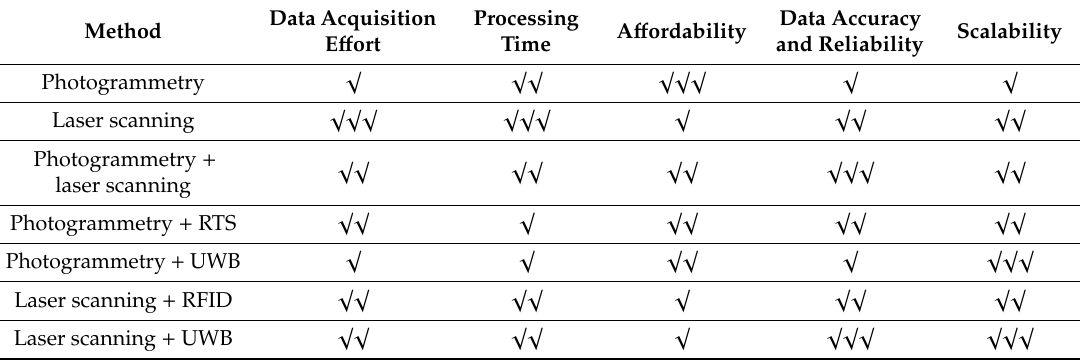
Table 4. Capabilities of individual and integrated vision-based